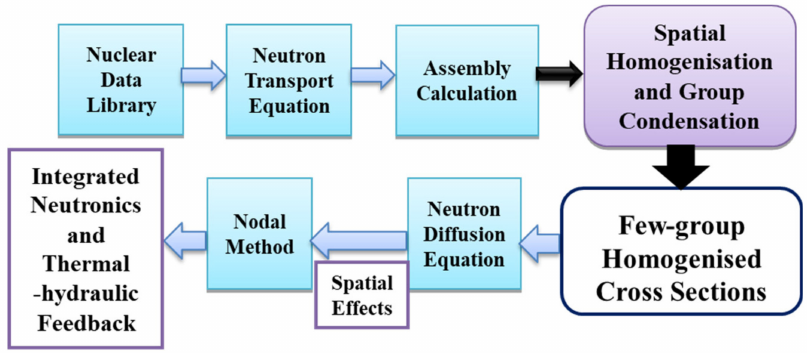
Figure 1. Principle of computational neutronics in full-core